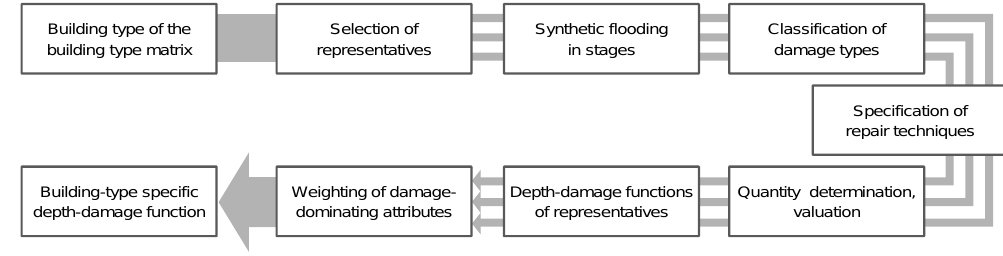
Fig. 3. Procedure to generate depth-damage functions due to groundwater inundation (Naumann et al., 2009, modified).